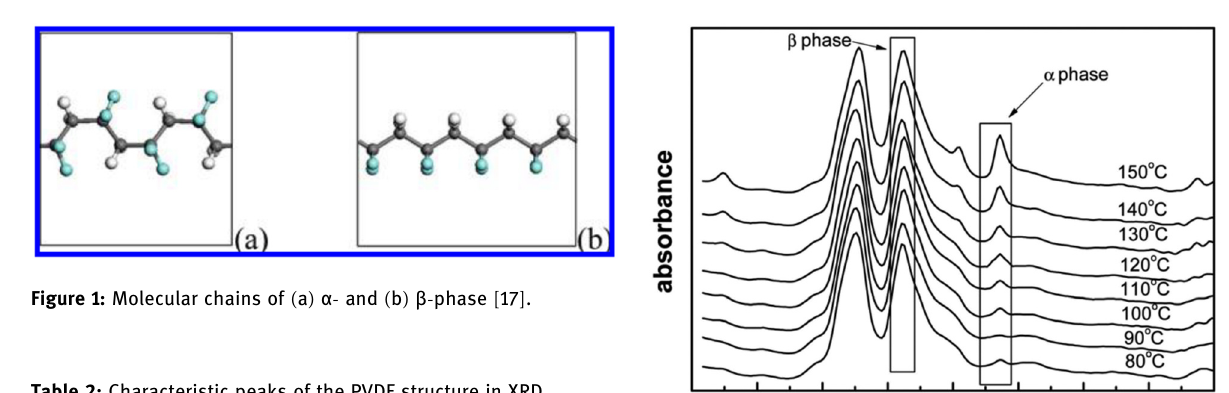
Table 2: Characteristic peaks of the PVDF structure in XRD spectra [ 3,18 ]